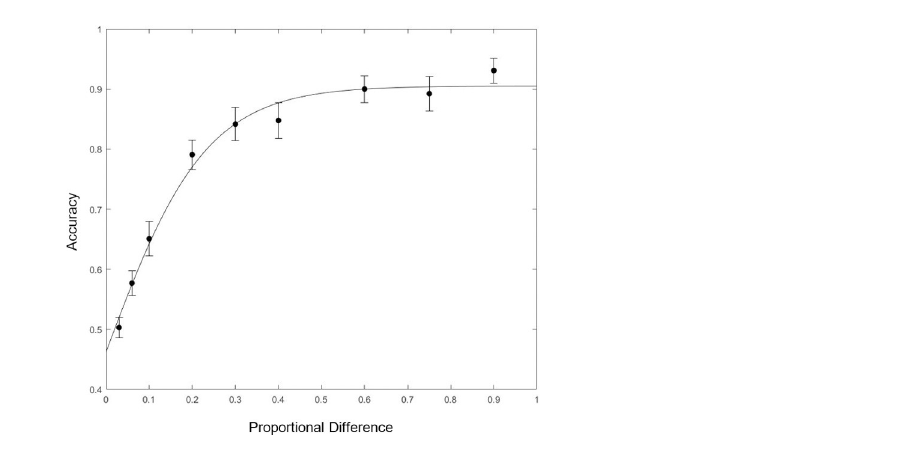
Fig 3. Performance as a function of curvature difference. The horizontal axis gives the proportional difference between curvatures for the two-segment contour fragment. For example, if the proportional difference is 0.1, then the curvature ratio between the two segments is 1.1:1. Error bars indicate ± one standard error of the mean.